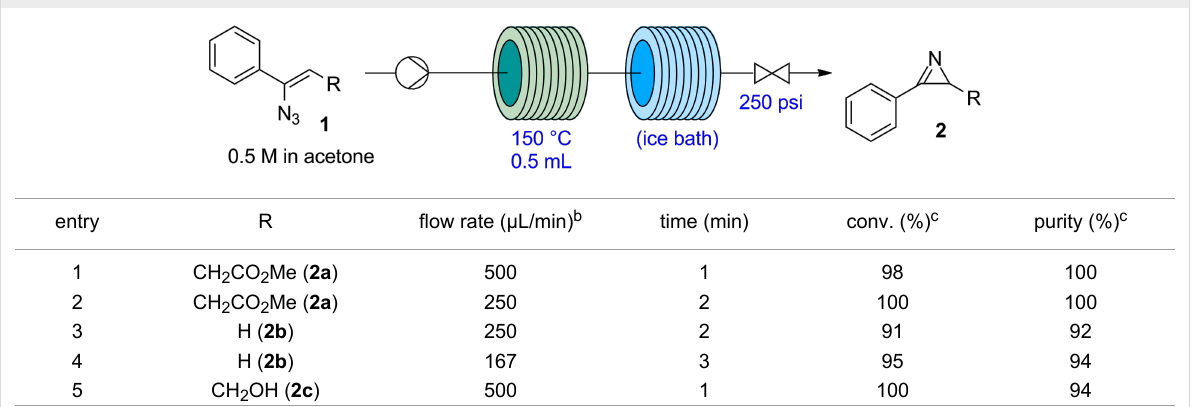
Table 4: Continuous-flow generation of azirines 2 by thermolysis of vinyl azides 1 .